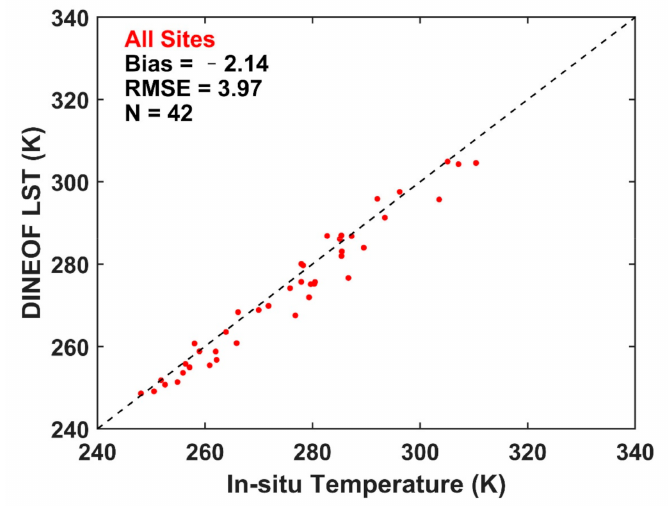
Figure 14. The scatter plot of the in situ temperature and the all-weather LST